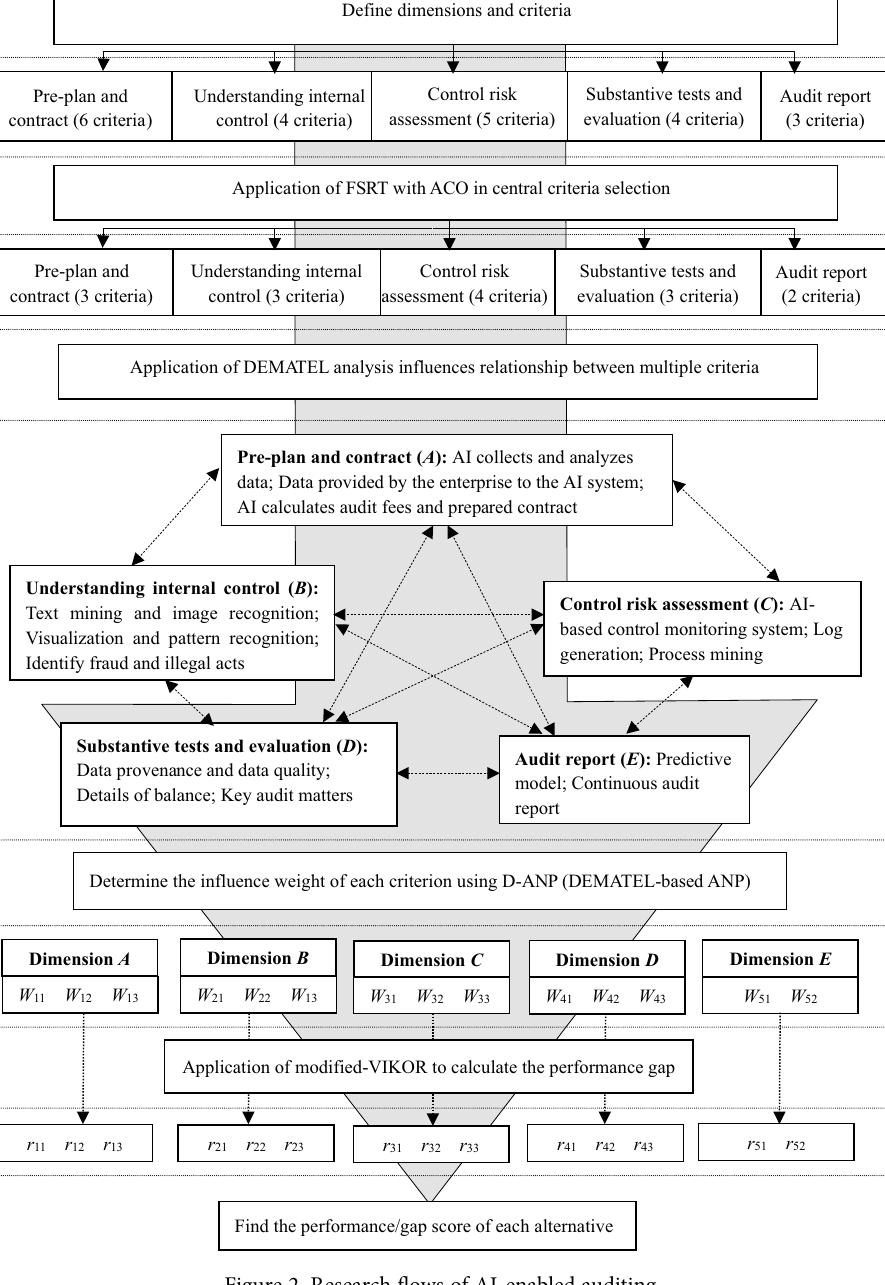
Figure 2. Research flows of AI-enabled